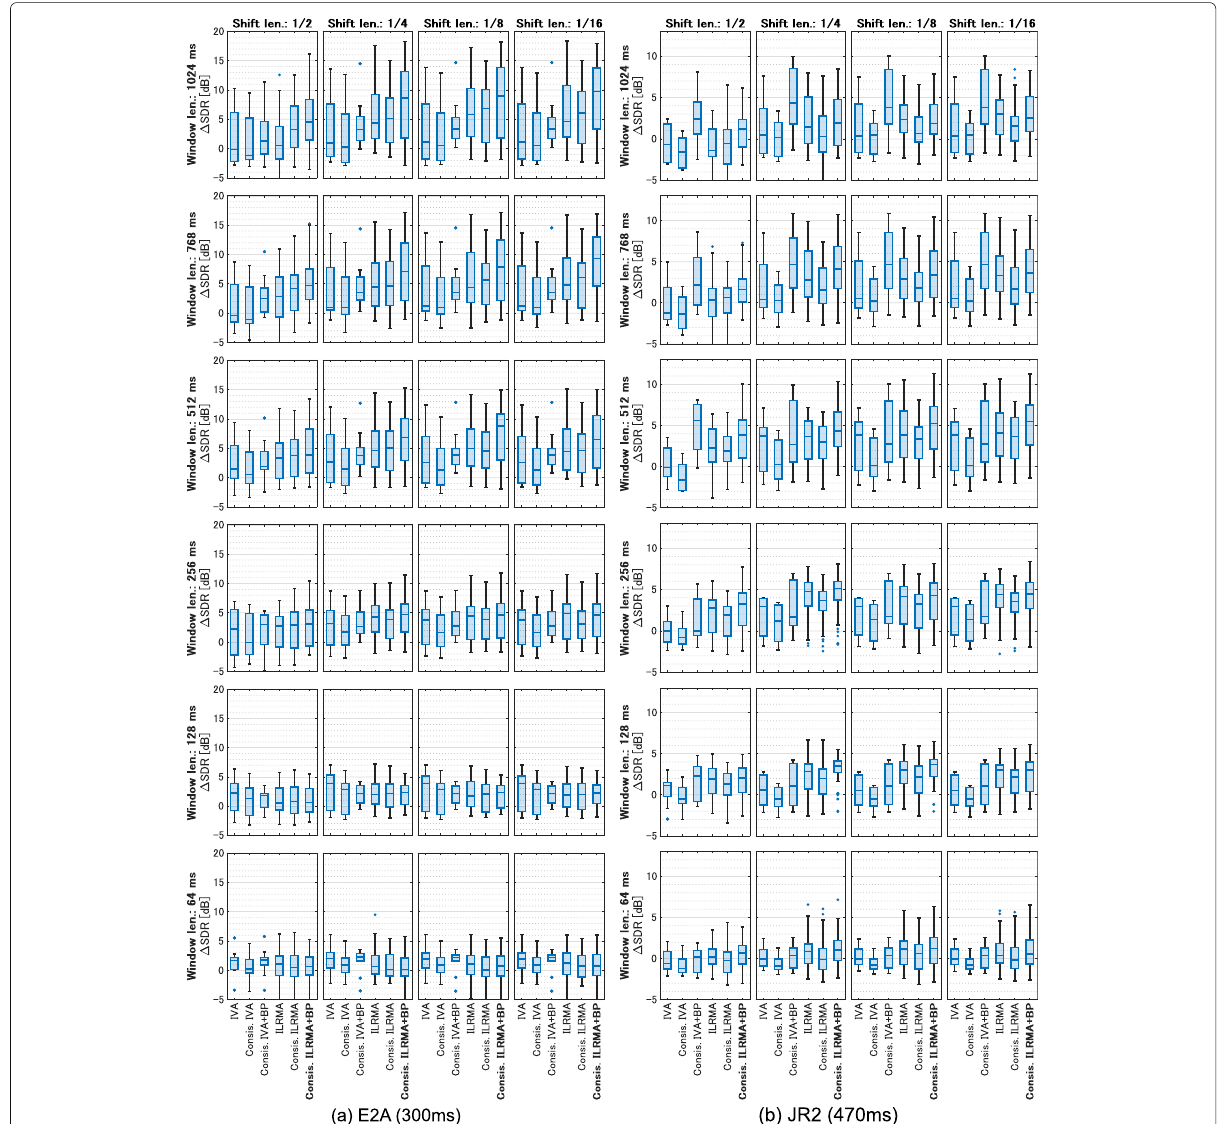
Fig. 15 Average SDR improvements for synthesized speech mixtures (speech 1–10) with a E2A and b JR2 , where Blackman window is used in